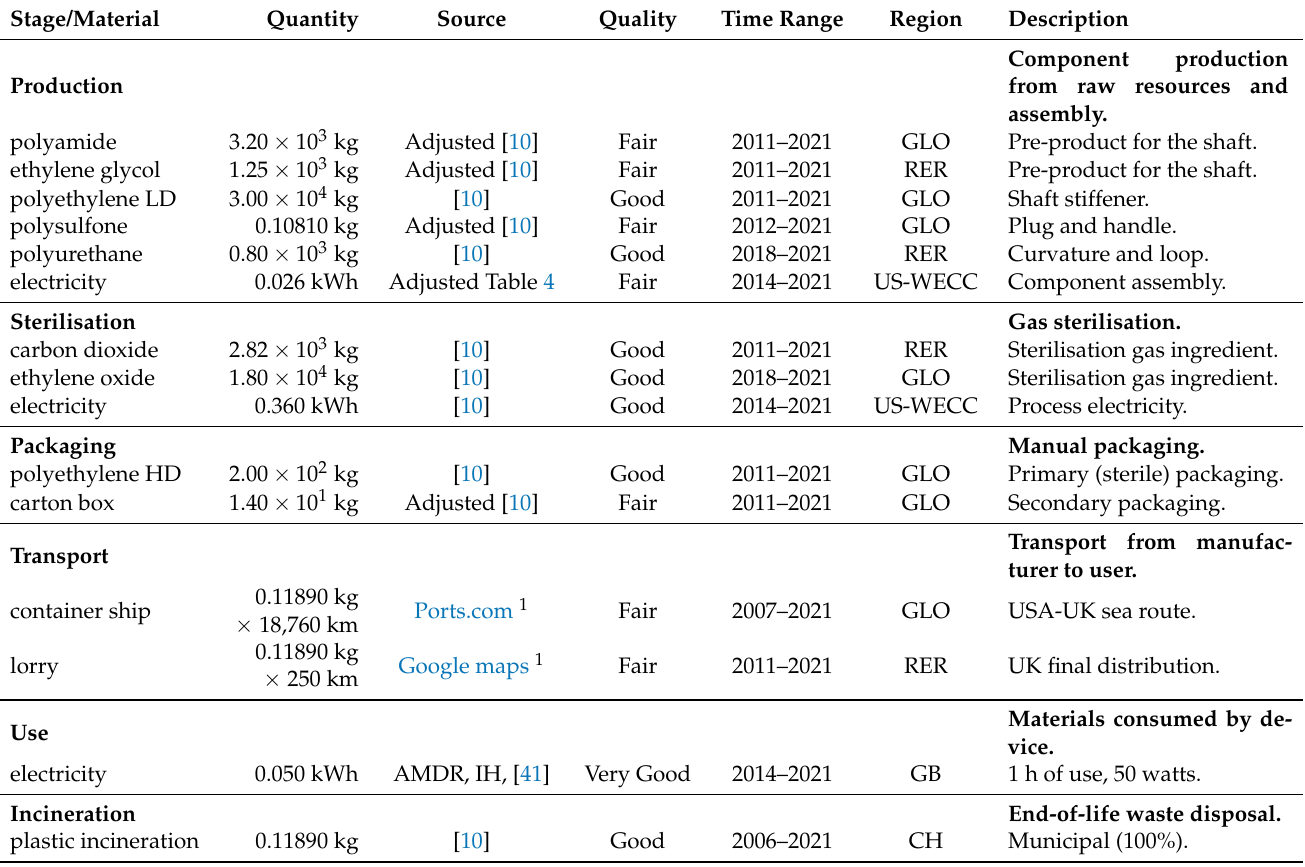
Table 3. Virgin life stages and materials . The materials are based on [10] and supplemented with primary data from our collaborators, medical device remanufacturers AMDR and Innovative Health. The data quality was assessed with the rubric in Table 2, and the region marks the Ecoinvent production